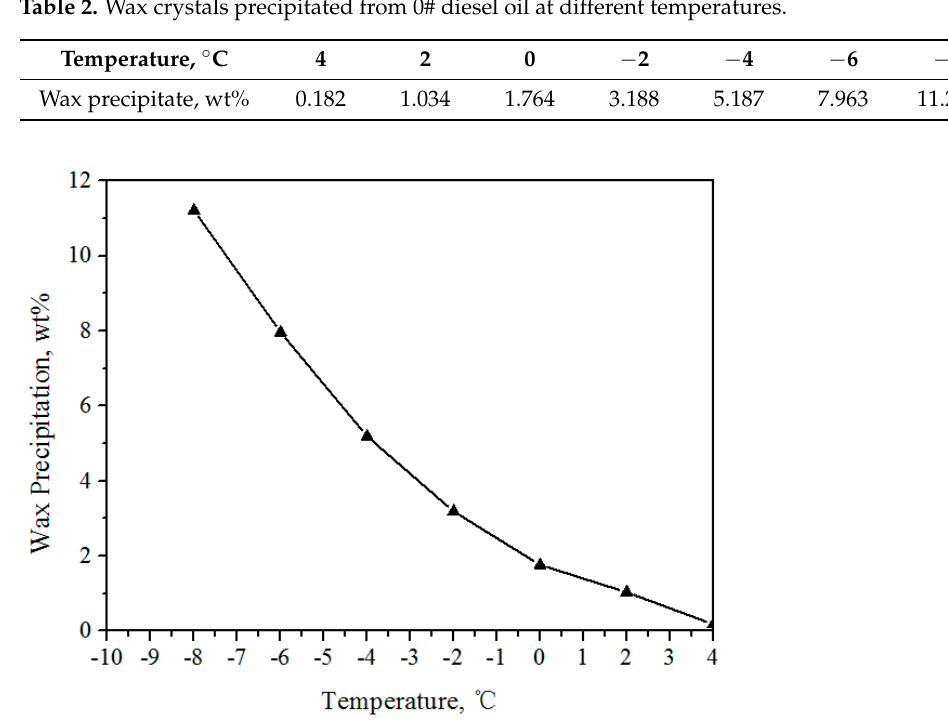
Figure 15. The amount of wax precipitated at different temperatures of 0# diesel. Liquid phase and solid phase compositions of 0# diesel at 4 °C, 0 °C, − 4 °C and − 8 °C, as shown in Table 3 and Figure 16. Table 3. Liquid phase and solid phase compositions of 0# diesel at different temperatures.